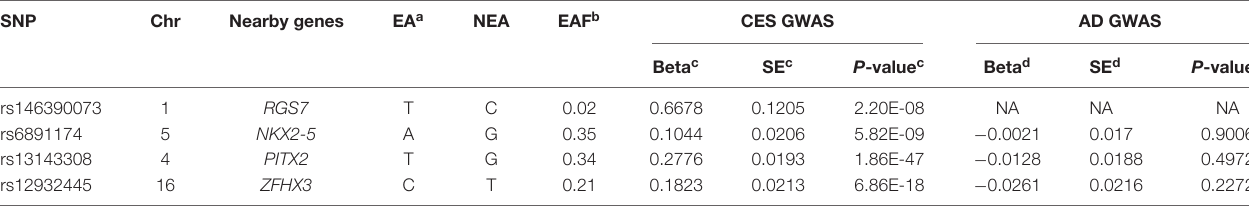
TABLE 4 | Characteristics of four genetic variants in CES and AD GWAS